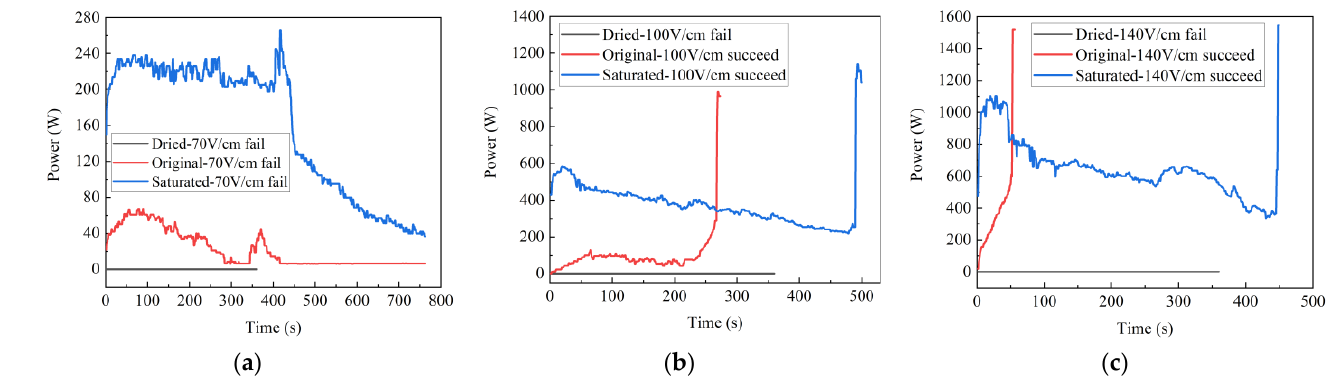
Figure 10. Heat generation power variation with time in the different moisture content experiments. ( a ) Electric field intensity of 70 V/cm; ( b ) electric field intensity of 100 V/cm; ( c ) electric field intensity of 140